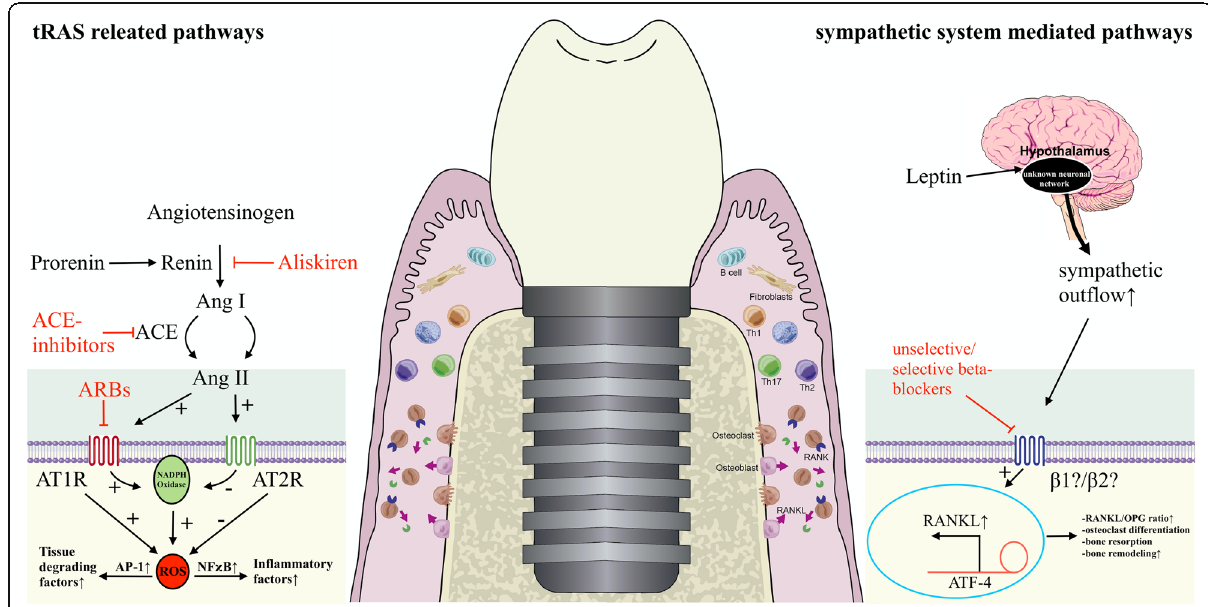
Fig. 1 Illustration of the potential role of beta-blockers and RAS inhibitors in peri-implant bone remodeling processes. AP-1, activator protein 1; ARB, angiotensin II type 1 receptor blocker; RANKL, receptor activator of nuclear factor-kappa β ligand; OPG, osteoprotegerin; ATF-4, activating transcription factor 4; ROS, reactive oxygen species; NF-k β , nuclear factor-kappa β ; ACE, angiotensin-converting enzyme; Ang, angiotensin; AT1R, angiotensin II type 1 receptor; AT2R, angiotensin II type 2